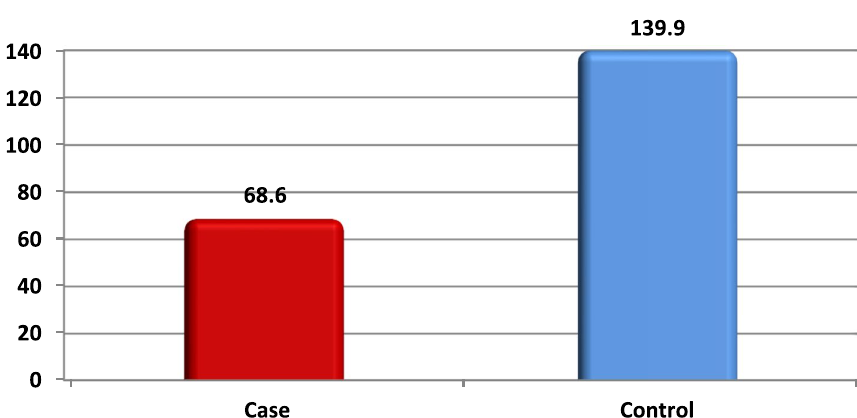
Fig. 3 Oxytocin level in different study groups